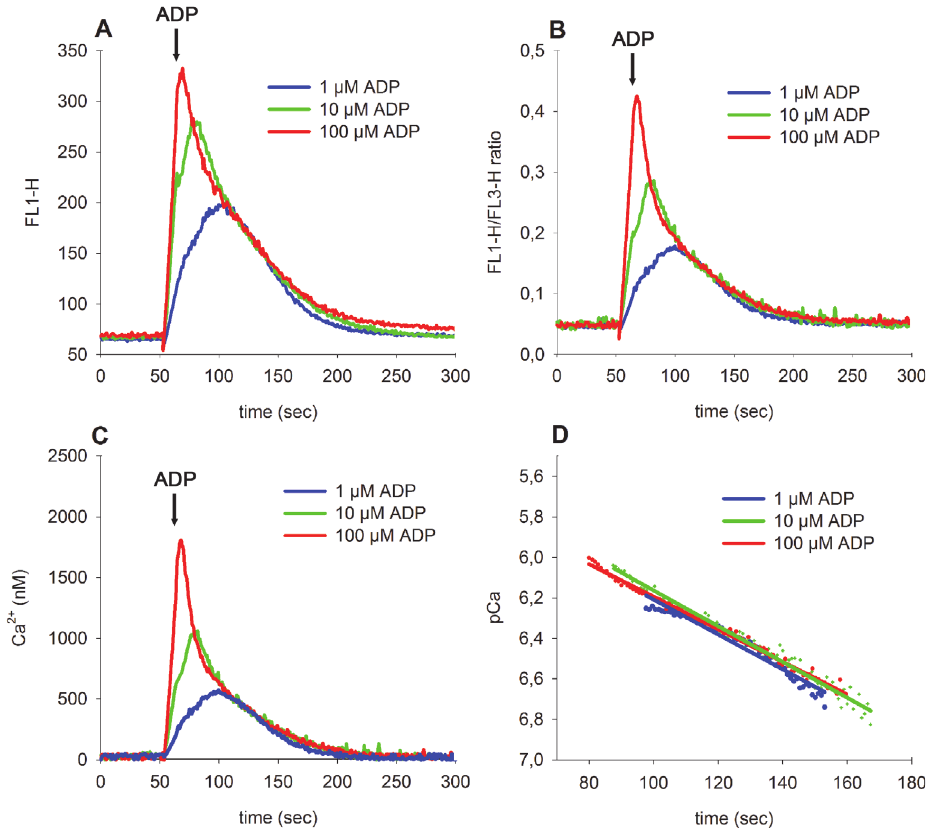
Fig 5. The effect of platelet activation by different concentrations of ADP (1 – 100 μ M) on intraplatelet [Ca 2+ ] i dynamics over time. (A) Time course of time-averaged FL1-fluorescence. (B) Time course of time- averaged FL1/FL3 ratios. (C) Time course of [Ca 2+ ] transformed from FL1/FL3 ratios using Equation 10A and 10B (see Methods Section). (D) Log 10 -transformed ratios in the descending part of traces from subfigure C are shown as dots. Linear regression lines in the same colour were fitted to these data points. ADP was added 50 seconds after initial recording as indicated by an